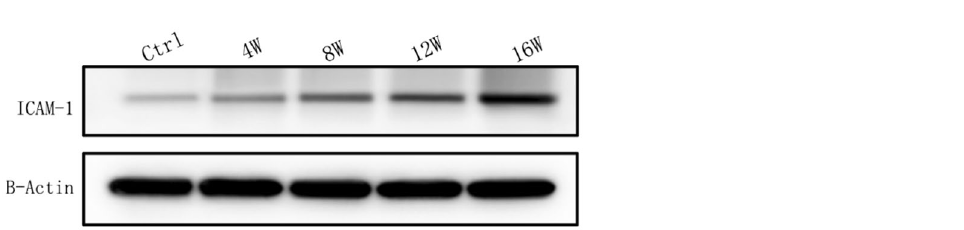
Figure 5. Comparison of the intima-media membrane thickness of 2D ( A ), SonoVue ultrasonic contrast ( B ) and intensity of abdominal wall of experiment rabbits of ICAM-1-targeted nano ultrasonic contrast ( C ), five rabbits in each group. *Indicates significant difference from the groups * P < 0.05, all values presented as mean ± standard deviation. The correlation analysis of the OD of ICAM-1 and the vascular wall intensity (D). Data analysis and images were created by using SPSS 19.0 (IBM, Armonk, NY, USA).